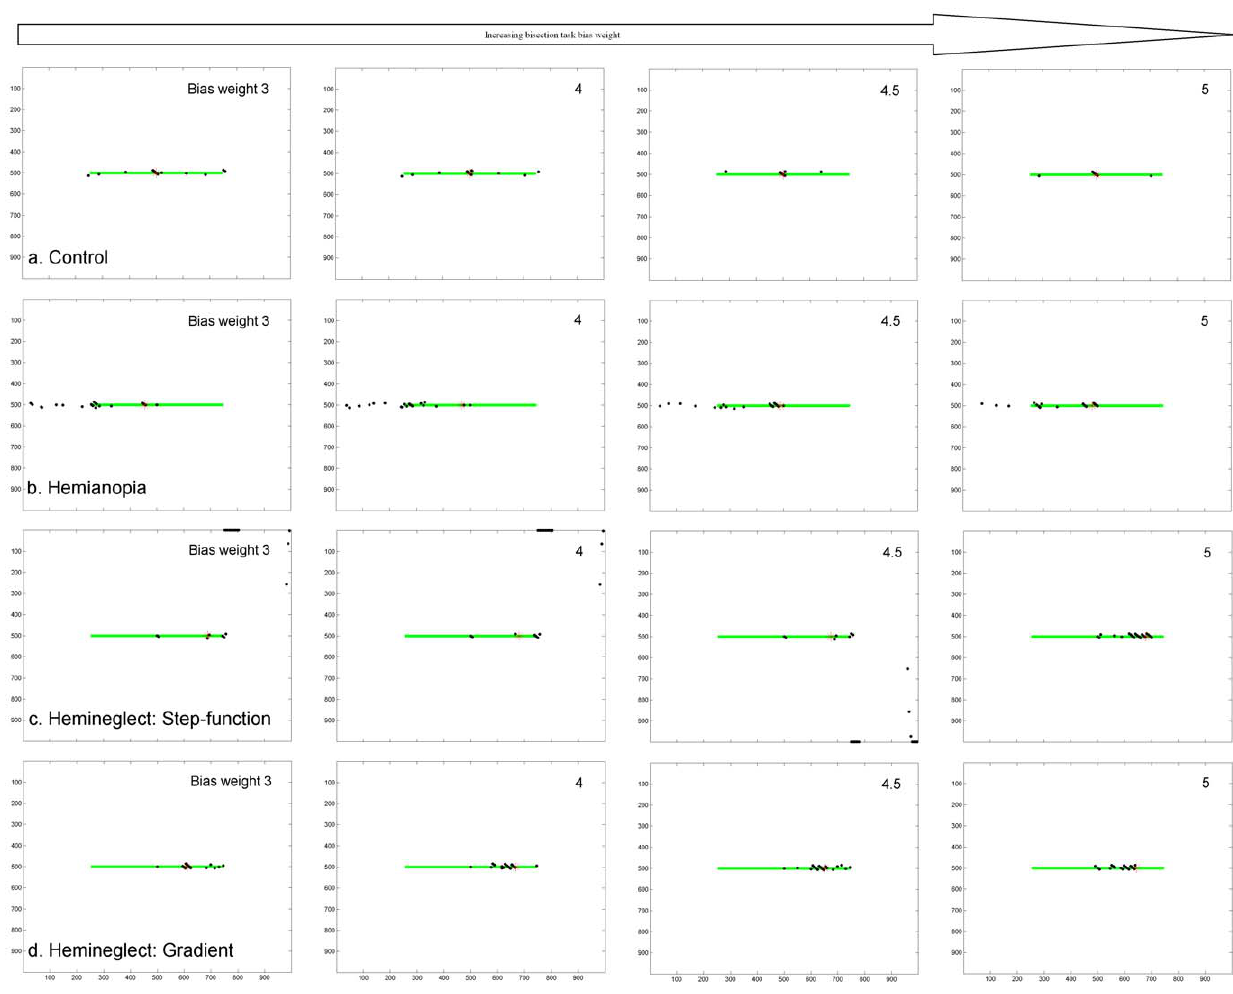
Figure 9. Example Scanpaths Showing the Effect of Lesion Condition and Bisection Task Bias on Line Scanning & Bisection. Each sub- plot shows the position of scanpath fixations (black dots) and point of line bisection (red asterisk) under various healthy and lesion conditions when the bisection bias weight was systematically raised, being set to the following values in order left to right: 3, 4, 4.5, 5. Axes refer to pixel position in the scene. a. Intact model. Raising the weight of the bisection task bias has the effect of concentrating the scanpath at the line centre. Bisection was consistently at line centre, position 500 (zero error). b. V1 lesion model. Raising the weight of the bisection task bias causes more fixations to be clustered around the location, offset contralesionally to line centre, which will later become the bisection point. As the task bias weight increases, less fixations are placed at the contralesional line end, but this is still where the majority of fixations are made. Bisection points were always contralesionally offset, in these simulations, from left to right, being: 455 ( 2 4.1 u offset, 9.1% of line length error), 468 ( 2 2.9 u offset, 6.5% error), 488 ( 2 1.1 u offset, 2.4% error), 482 ( 2 1.6 u offset, 3.6% error). c. Parietal lesion model using a step-function. If the weight of the bisection task bias is weak, the scanpath does not stay on the line. Bisection points were always highly ipsilesionally offset, in these simulations, from left to right, being: 688 (17.1 u offset, 38.0% of line length error), 680 (16.4 u offset, 36.4% error), 674 (15.8 u offset, 35.2% error), 681 (16.5 u offset, 36.6% error). d. Parietal lesion model using a gradient. Bisection points again were highly ipsilesionally offset, in these simulations, from left to right, being: 611 (10.1 u offset, 22.4% of line length error), 669 (15.4 u offset, 34.1% error), 652 (13.8 u offset, 30.7% error), 644 (13.1 u offset, 29.1% error).